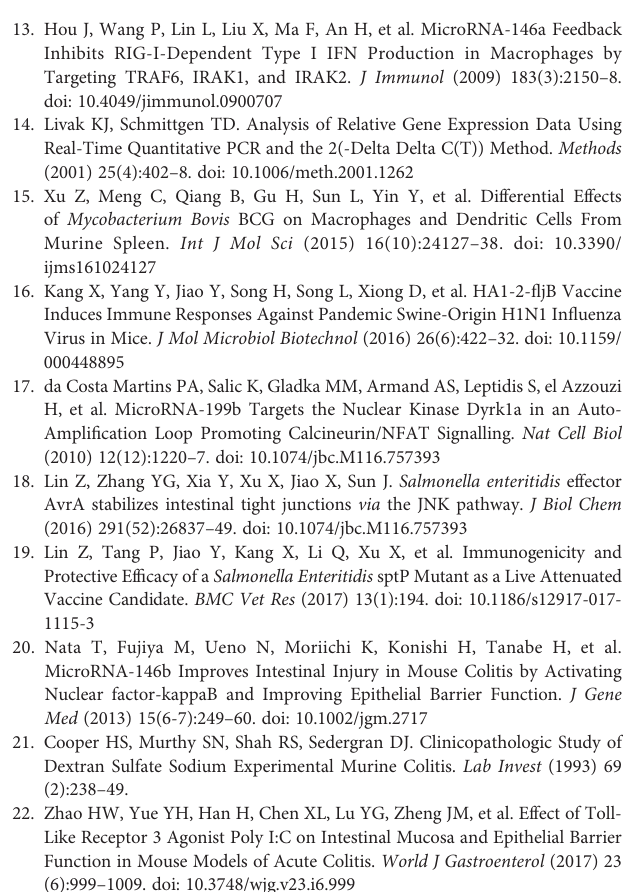
Supplementary Figure S2 | Activation of BMDCs induced by fl agellin. The sorted BMDCs were cultured with 100 ng/ml fl agellin or medium alone for 24 h. The expression of surface markers (CD40, CD80, and CD86) in BMDCs was analyzed by FCM. FCM histograms indicate the fl uorescence intensity of surface marker (A) . The expression of surface markers is also presented as mean fl uorescence intensity (MFI) (B) . IL-12 p40 productioninculture supernatants ofBMDCs was measured byELISA using a mouse IL-12 p40 ELISA Kit (C) . The data shown represent the means ± SEM from 3 independent experiments. * P < 0.05, *** P < 0.001. Supplementary Figure S3 | The analysis of miR-5112 expression in peritoneal macrophages after the mice were infected with S. enteritidis . The mice were administered to 7.5 mg of streptomycin by oral gavage. After 24 h, the mice were infected with 5 ×10 4 CFU of C50336 (100 - m l of bacterial suspension in PBS) or treated with 100 m l of sterile PBS (control) by oral gavage. At 8 hours after Salmonella infection, three mice per group were sacri fi ced, and the peritoneal macrophages were collected. The expression of miR-5112 in peritoneal macrophages were determined by qRT-PCR. Supplementary Figure S4 | The analysis of miR-5112 level in organs of mice after injection with agomiR-5112. The mice were intraperitoneally injected 2.5 nmol of agomiR-5112 on three consecutive days. Then, three mice per group were sacri fi ced, and the peritoneal macrophages, spleen and colon were collected. The miR-5112 levels in organs were determined by qRT-PCR. Supplementary Figure S5 | The analysis of miR-5112 expression in peritoneal macrophages and colon of DSS-induced colitis mice. The colitis model was induced with 4% DSS in C57BL/6 mice. The mice (n=3/group) were sacri fi ced, and the peritoneal macrophages, and colon were collected after mice exposed to DSS for 6 days. The miR-5112 levels in organs were determined by